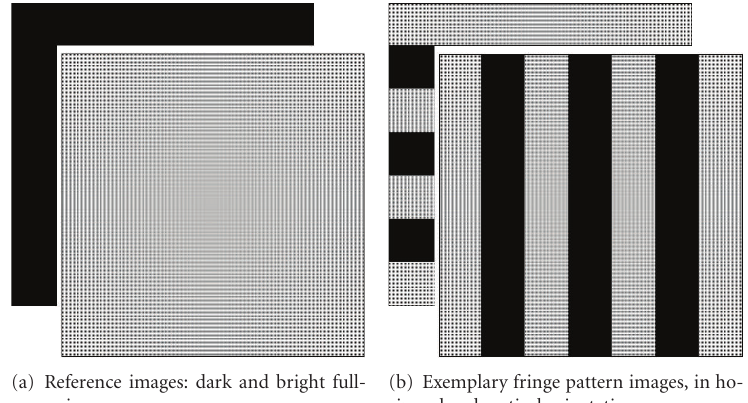
Figure 7: Simulated test images, which are used as source images for the projection